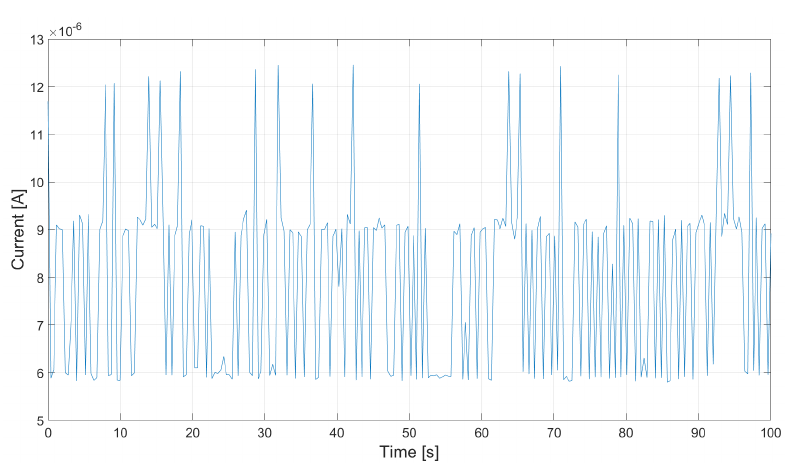
Figure 20. Current consumption during sleep state of the